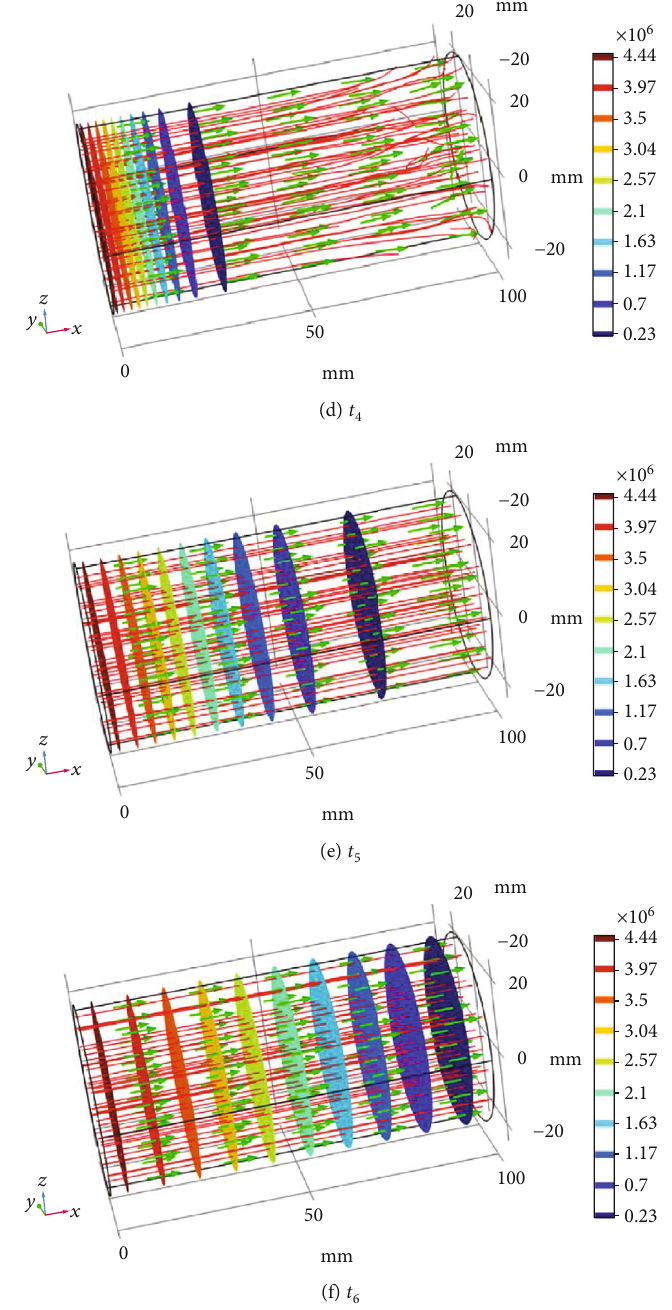
Figure 9: Relationship between pore water pressure and fl ow fi eld over